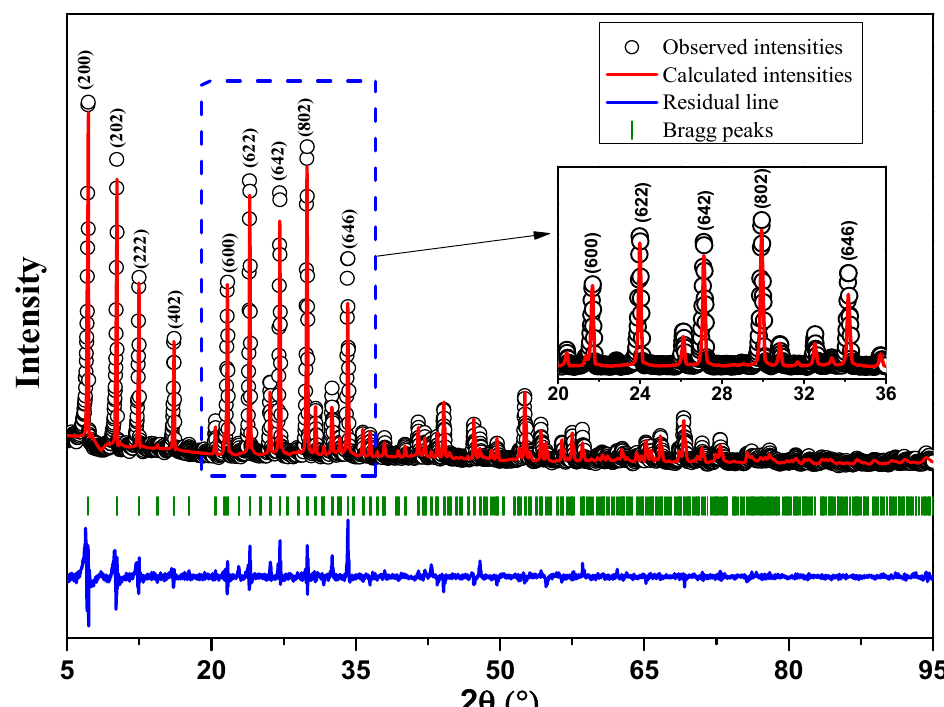
Figure 4. Refinement of zeolite 5A indicating the respective Miller indices obtained using MatchV3 software. The graph shows the observed intensity (white circles), calculated intensity (red line), and the difference between the observed and calculated intensities (blue residual line). The arrow indicates the region where the magnification was performed.